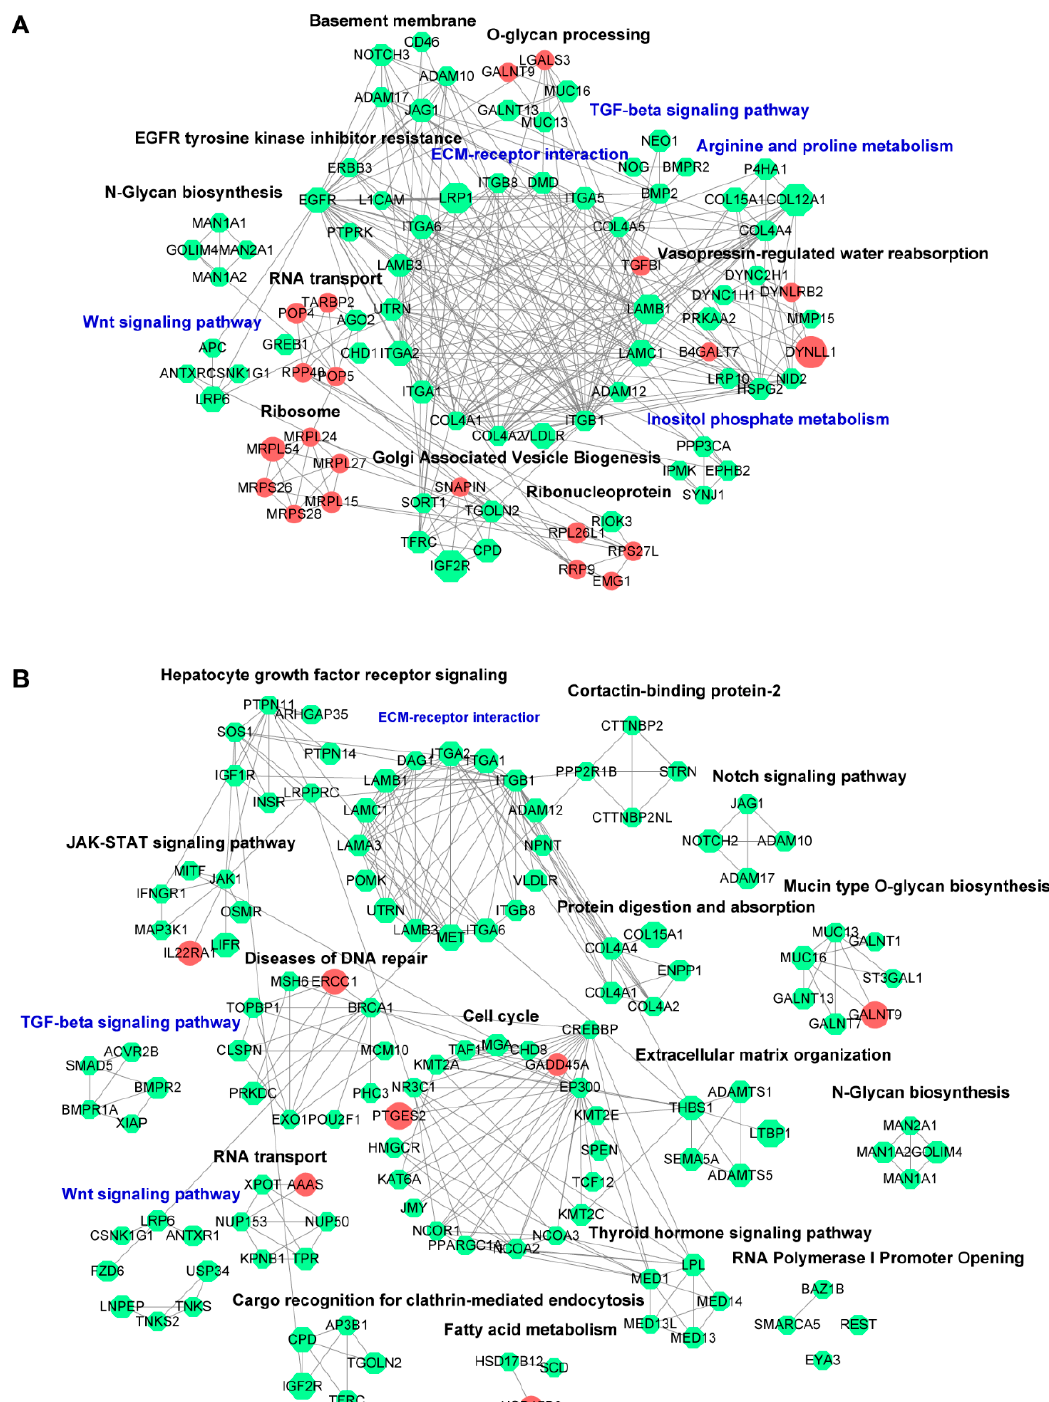
Figure 4. Protein–protein interaction network analysis. ( A ) Interactions of upregulated and down- regulated differentially expressed genes (DEGs) under CPUL1 exposure for 6 h. ( B ) Interactions of upregulated and downregulated DEGs under CPUL1 exposure for 48 h. The predicted protein prod- ucts of DEGs were entered in the STRING database (http://string-db.org/ accessed on 1 November 2022), setting an interaction score of 0.900. The nodes represent the protein products of the DEGs. Red and green represent the upregulation and downregulation, respectively, with the size correla- tive to the log2 (FC) value. Edges indicate the functional connections among nodes. The putative categories were annotated based on the functional association. DEGs were differentially expressed genes.